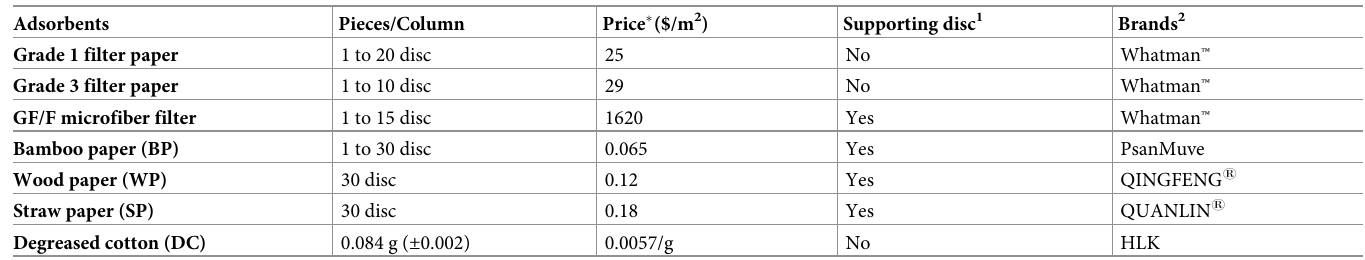
Table 1. Details of the selected